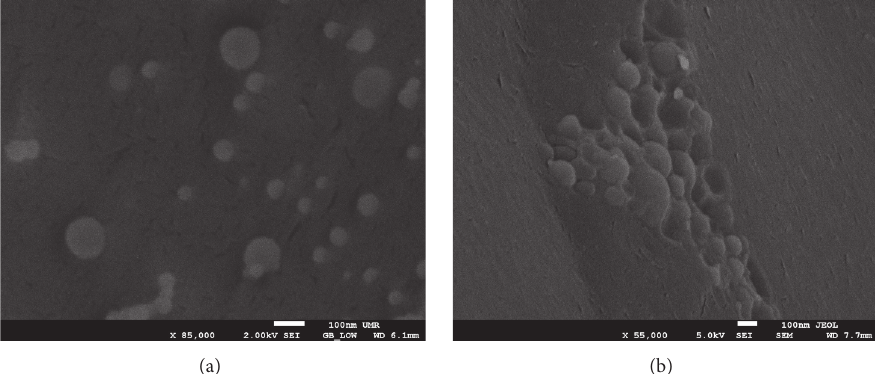
Figure 10: Cryo-SEM images of tetraether lipid containing liposomes. (a) hGDNT/DOTAP (5 :95) and (b) hGDNT/PC/CH/DOTAP (5: 30 : 35 :